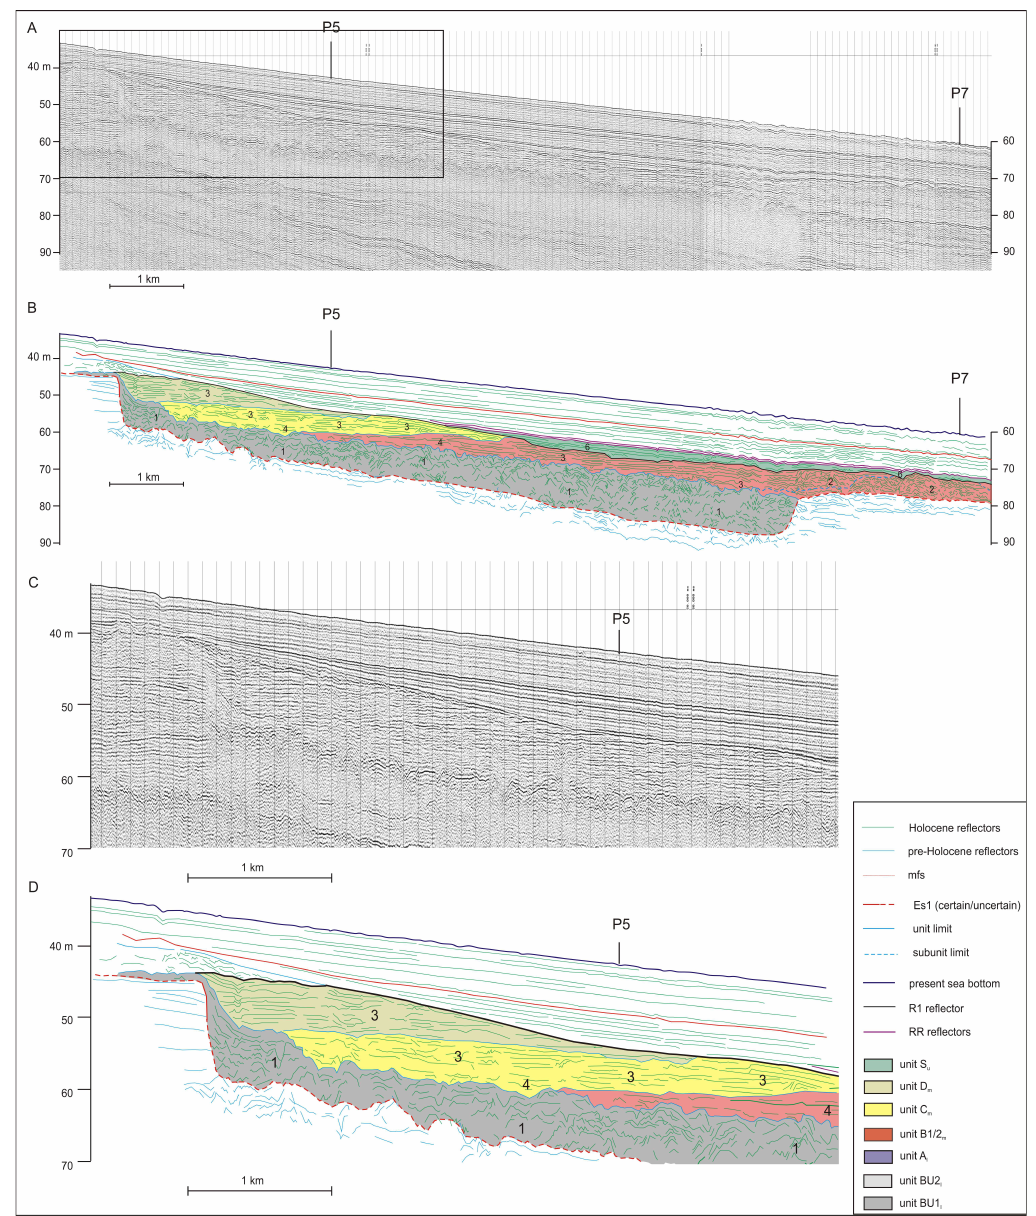
Figure 3. Part of seismic profile T3. Seismic section ( A ) and interpretation ( B ). ( C , D ) report an enlargement and its interpretation of the seismic profile sector included in the rectangle reported in ( A ). Note the Ofanto valley (OV) and the thick basal infilling by basal unit (BU)1 l , the coastal system of unit B m , with subunits arranged in continuous landward backstepping pattern, and the stratal pattern of units C m and D m with reflectors of seismic facies 3 and 4 that onlap onto basal unit BU1 l and are in turn truncated by surface R1. The legend reported in this figure applies for the following figures until Figure 10; the numbers reported in the interpretations of the figures indicate seismic facies; vertical scales are in metres below present sea